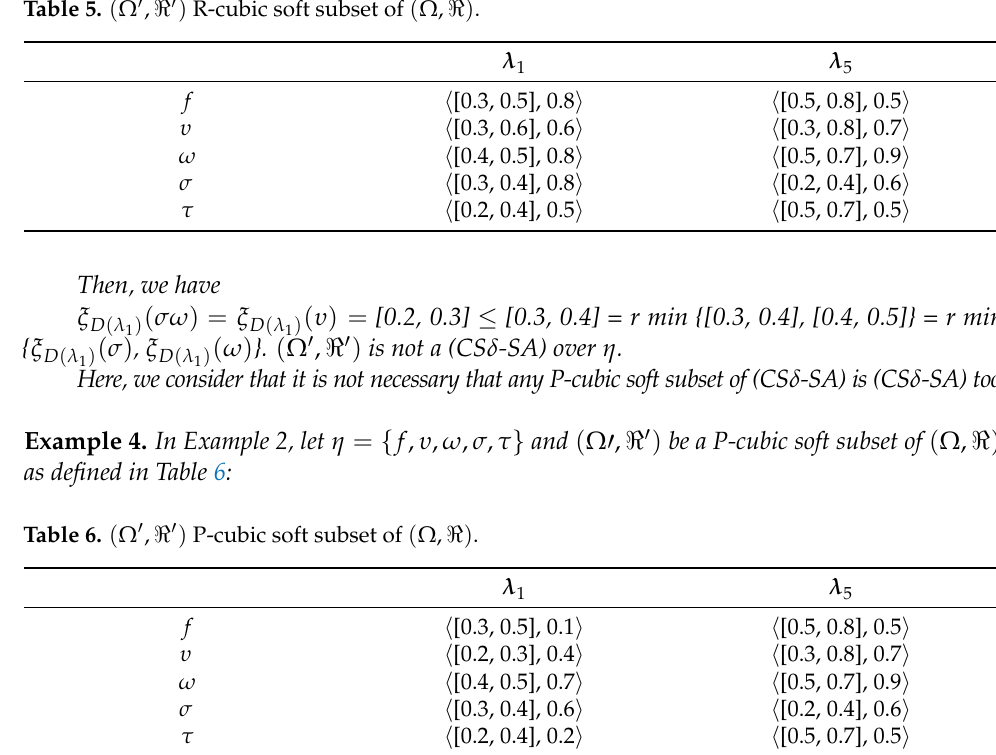
Table 5. ( Ω (cid:48) , (cid:60) (cid:48) ) R-cubic soft subset of ( Ω , (cid:60) ) .